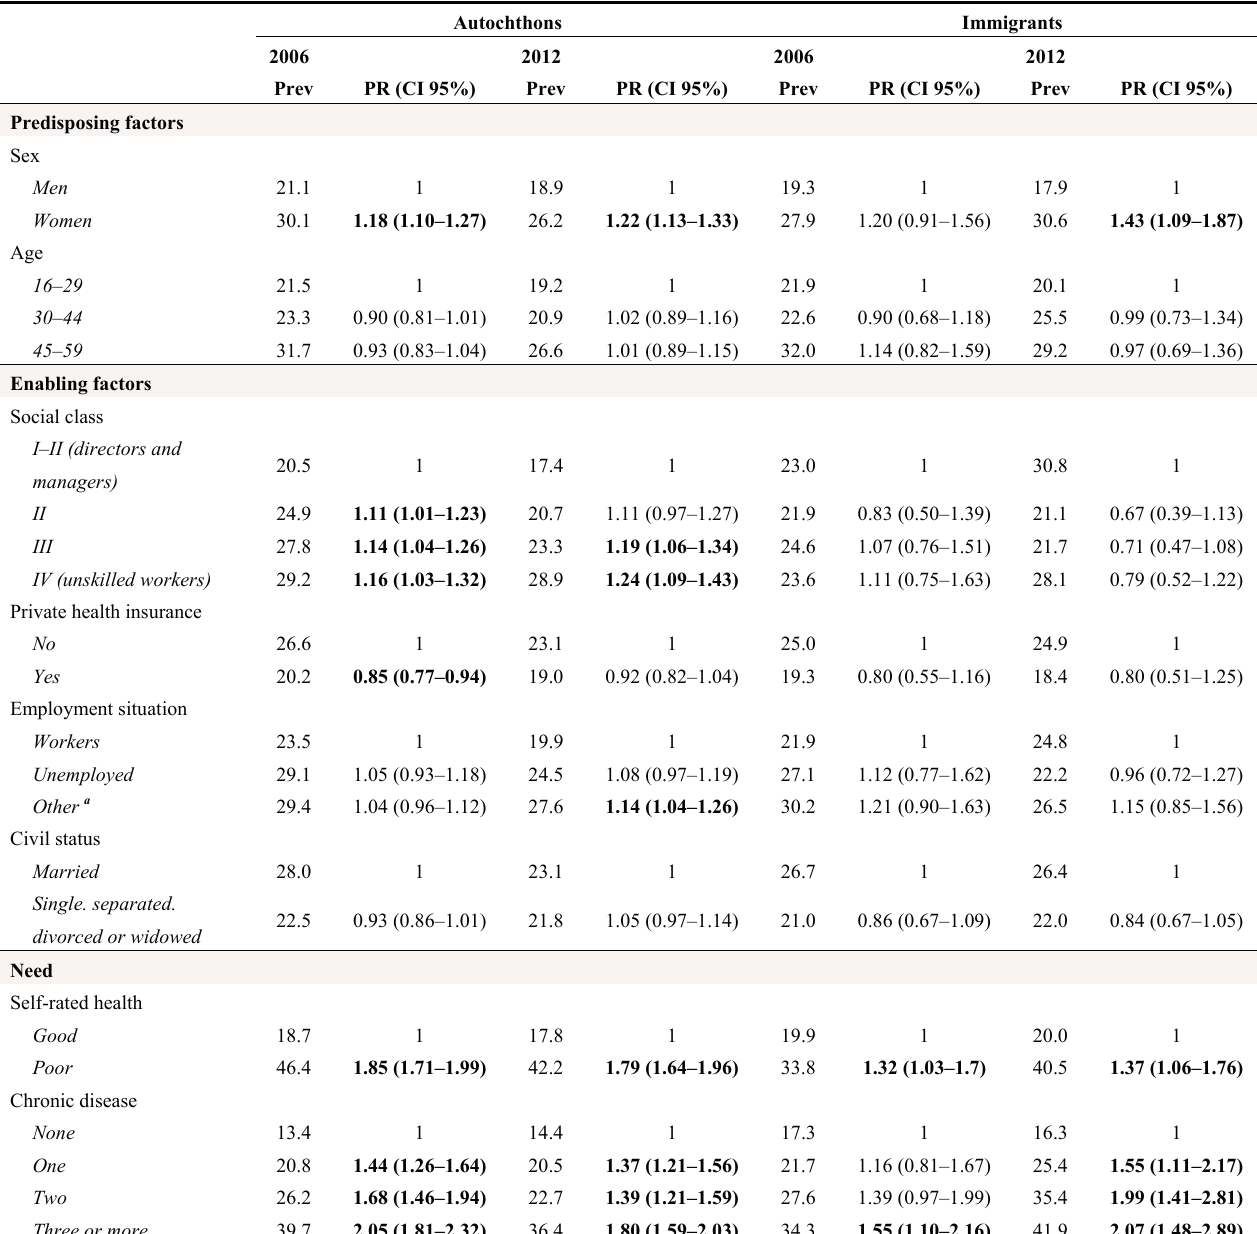
Table 3. Determinants of general practitioner visits in autochthons and immigrants in 2006 and